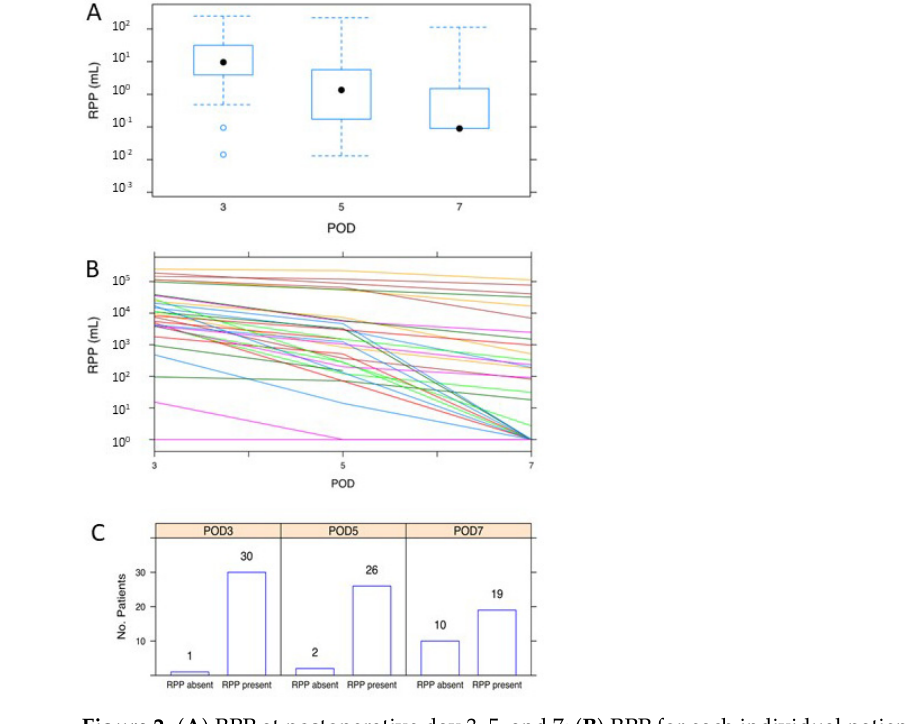
Figure 2. ( A ) RPP at postoperative day 3, 5, and 7; ( B ) RPP for each individual patient; ( C ) number of patients without any detectable RPP.